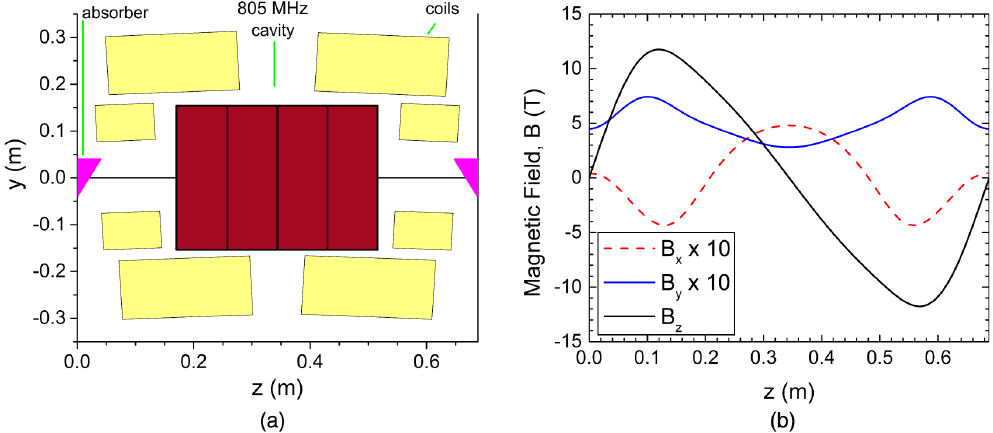
FIG. 4. (a) Side view of one cell for stage 11; (b) magnetic field on axis along the cell. The horizontal field B x is shown in red, the vertical field B y is shown in blue, and the longitudinal field B z is shown in black.